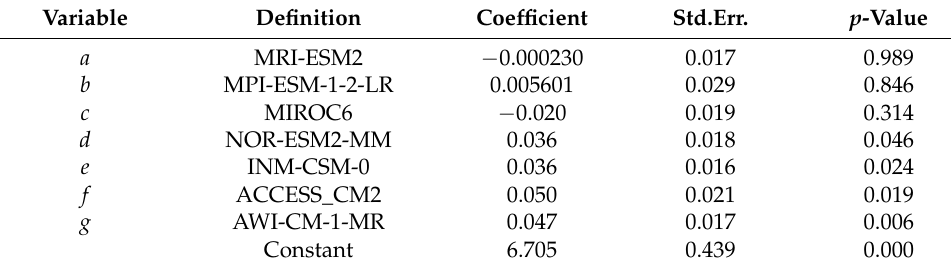
Table 3. Initial regression model of precipitation from selected GCMs as predictor variables.